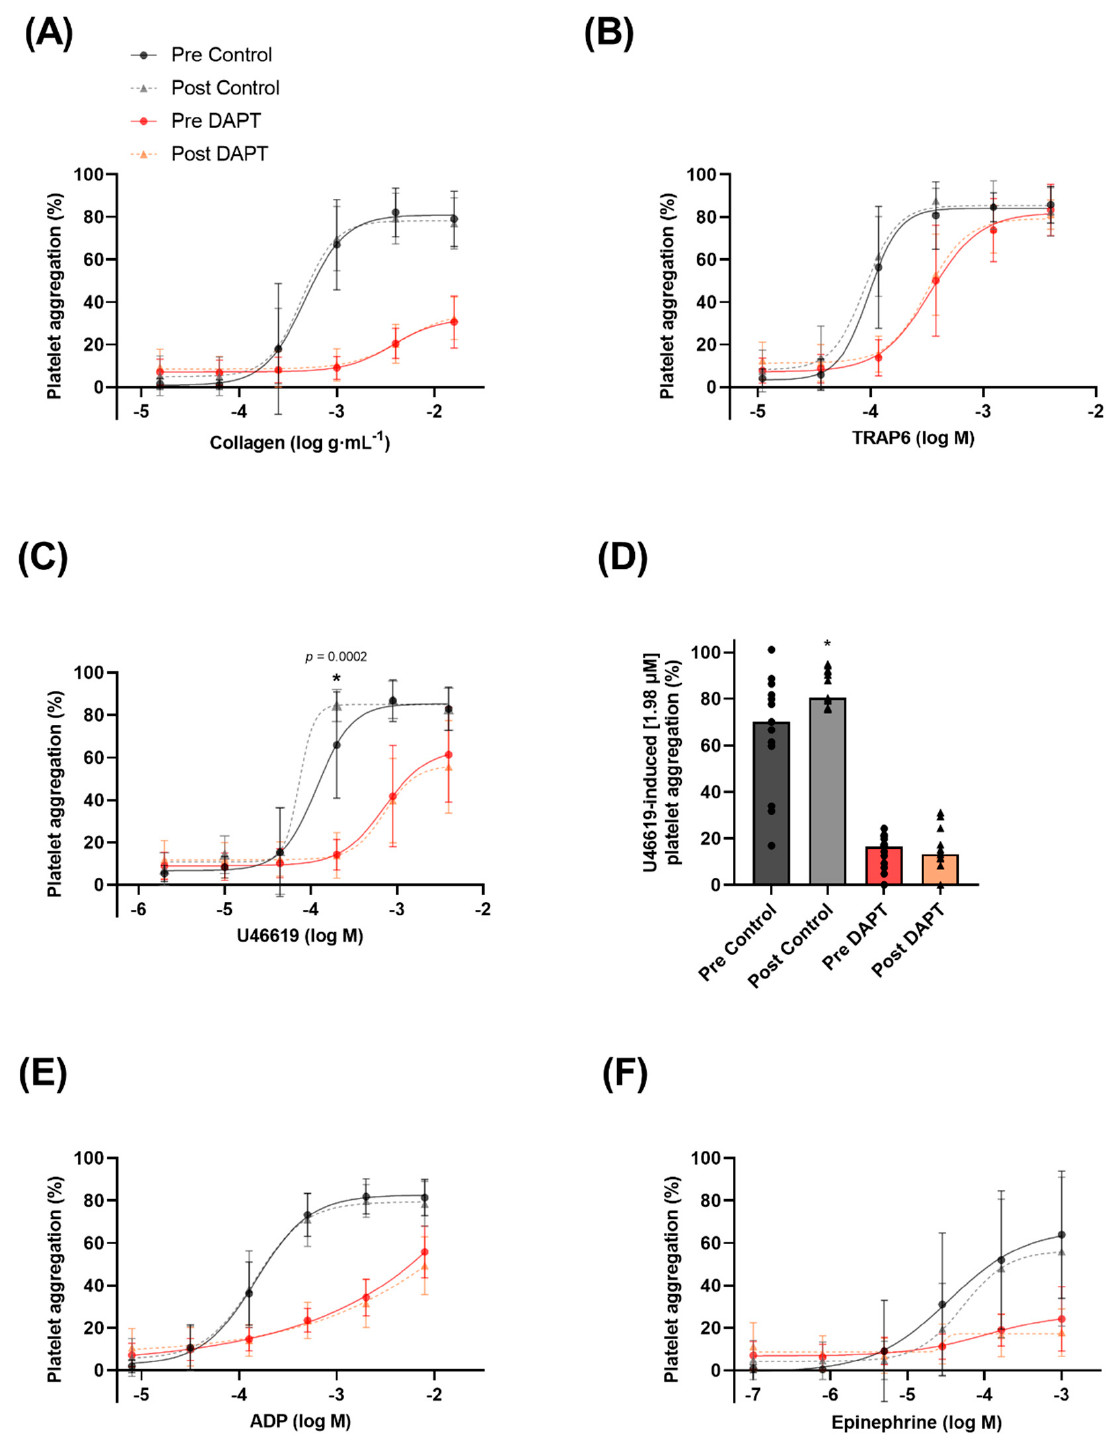
Figure 2. Basal platelet reactivity (expressed as platelet aggregation (%)) to 6 concentrations of the platelet agonists before and after 8 weeks of exercise training with and without dual anti-platelet therapy (DAPT): ( A ) collagen, ( B ) thrombin receptor activator peptide 6 (TRAP6), ( C ) U46619 (U4), ( D ) U46619-induced aggregation at (1.98 µM), ( E ) adenosine 5 ′ -diphosphate (ADP), and ( F ) epinephrine. *, indicates a statistically significant increase compared with pre-training ( n = 13 for all agonists).